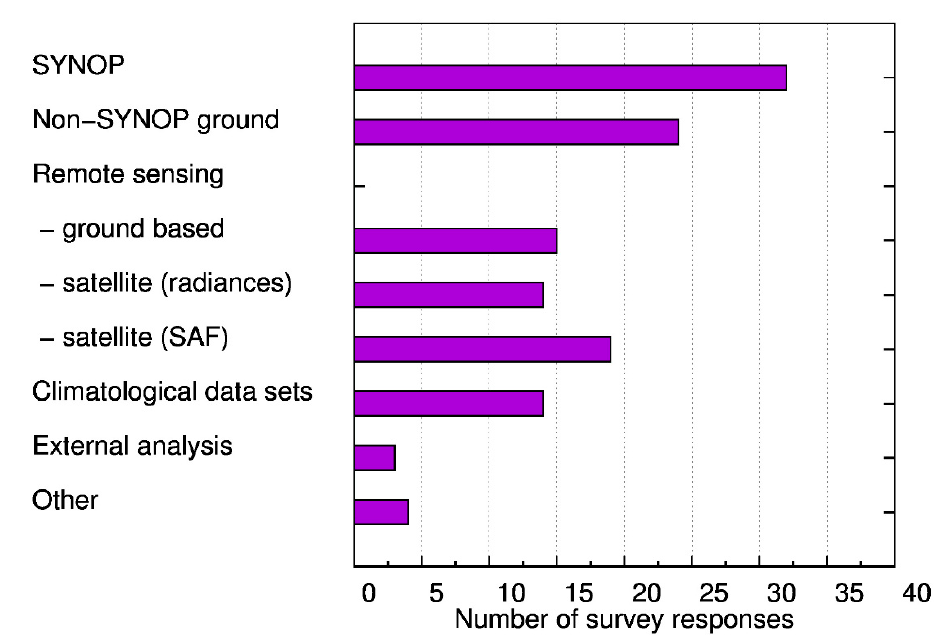
Figure 4. Snow observations and products used in the modeling system.